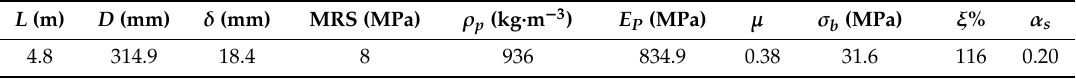
Table 1. Parameters of the polyethylene material and